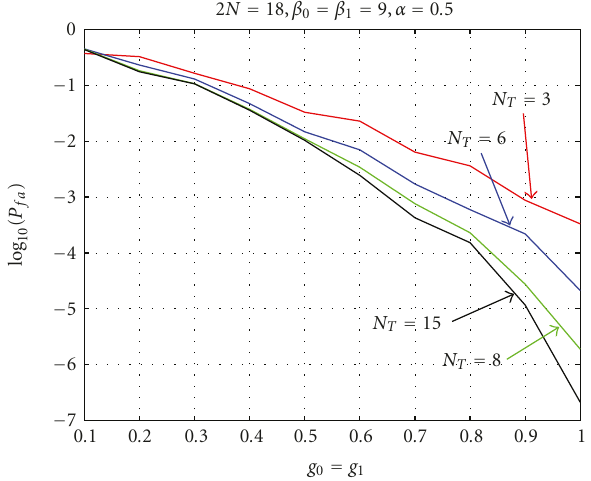
Figure 7: Comparison of P d for CA, GO, SO, OS ( k = N = 9 and k = 17), and SOS I processors (2 N = 18 and P fa = 10 − 5 ).